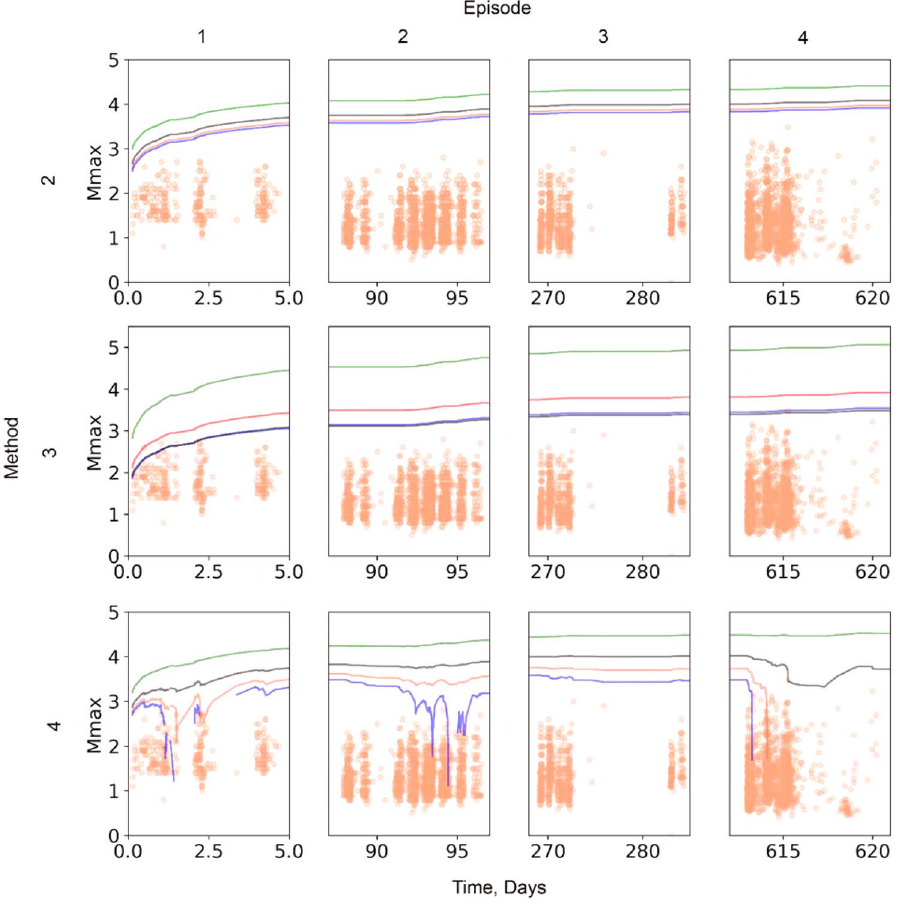
Figure 8. Sensitivity analysis based on the choice of the calibration window. Plots are grouped by method (row) and episode (column). Method one is not considered because it does not require any calibration parameter. Red, blue, black, and solid green lines denote the episode used for calibration, from 1–4, respectively. Orange symbols represent the observed